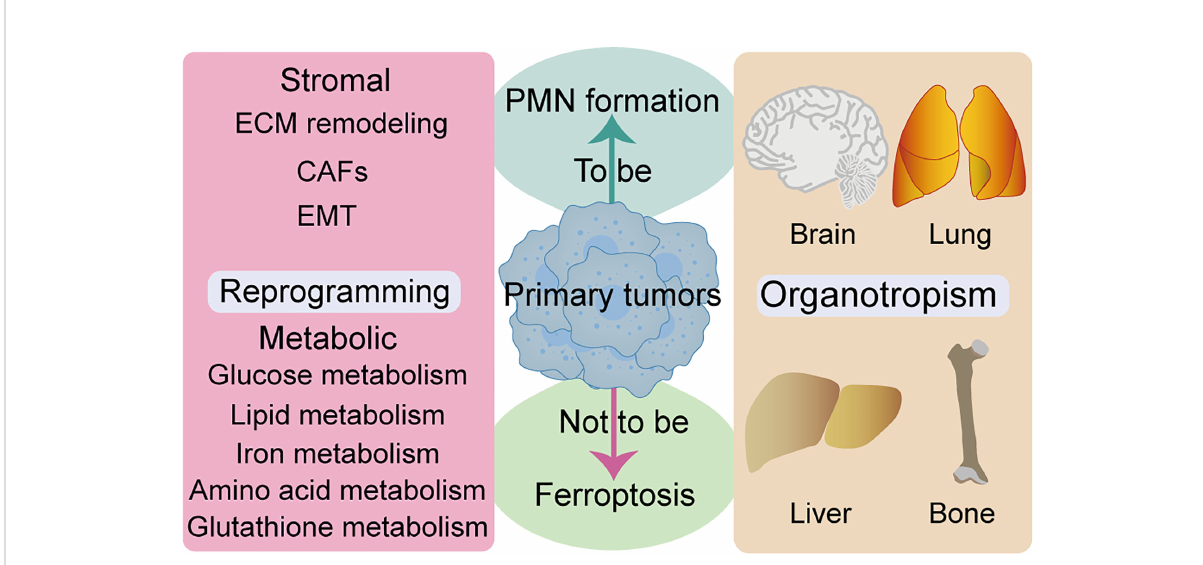
FIGURE 3 Relationship between ferroptosis and reprogramming and organotropism. ECM remodeling, CAFs, and EMT are closely associated to stromal reprogramming and ferroptosis. Multiple metabolic pathways are closely related to ferroptosis, such as glucose metabolism, lipid metabolism, iron metabolism, amino acid and glutathione metabolism. Several organs are the host parts of metastasis and are prone to ferroptosis, such as brain, lung, liver and bone. CAFs, cancer-associated fi broblasts; ECM, extracellular matrix; EMT, epithelial-to-mesenchymal